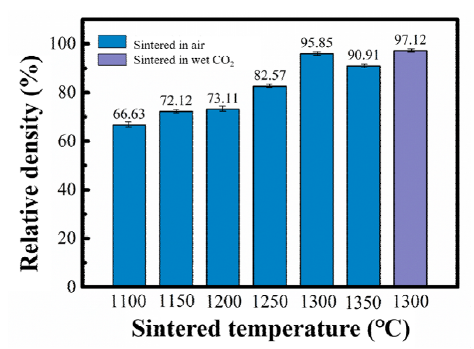
Fig. 5 Density of samples sintered with various sintering conditions.